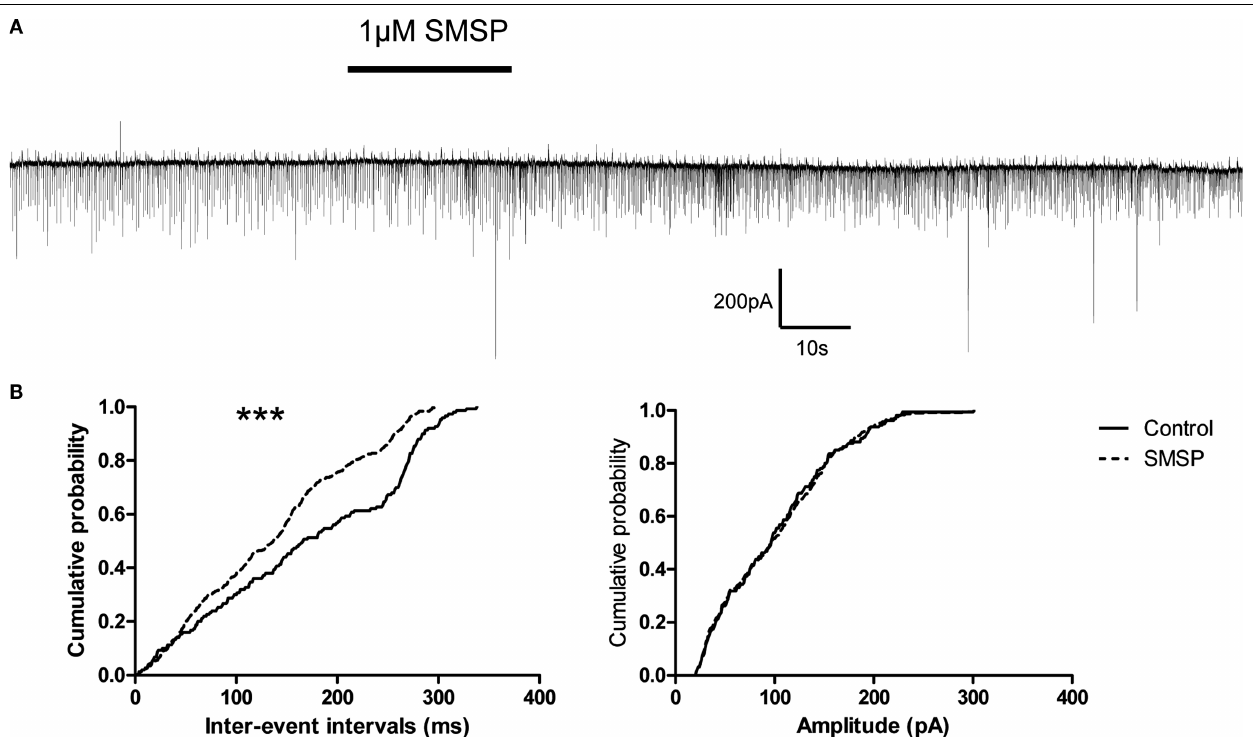
FIGURE 4 | Enhancement of sIPSCs by SM-SP. (A) The uppermost trace showed that application of 1 µM SM-SP signifi cantly increased the frequency but not the amplitude of sIPSCs recorded from a globus pallidus neuron. (B) The cumulative probability distributions of the inter-event intervals and amplitudes of the sIPSCs from the experiment shown in (A) . Signifi cant differences were found in the distributions of inter-event intervals. *** P <